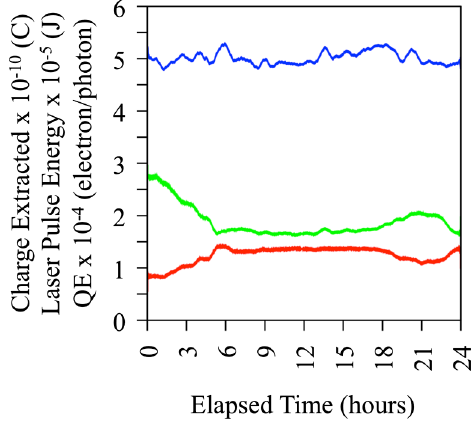
FIG. 6. 24 hr of continuous operation of a CsBr photocathode. The charge extracted is colored blue, the laser pulse energy is colored red and the quantum efficiency is colored